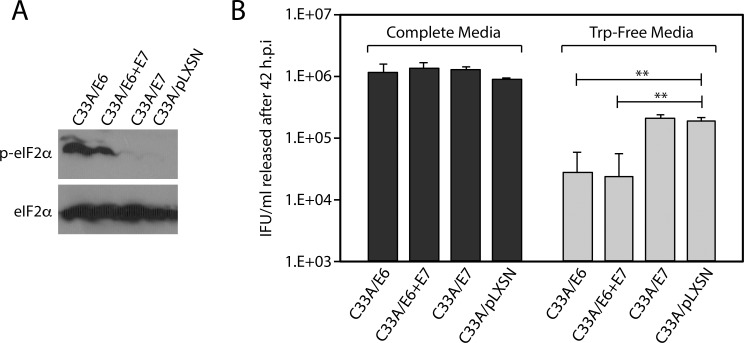
Expression of the HPV16 E6 oncogene in C33A cells accentuates the effect of tryptophan starvation on C. trachomatis development.Stable C33A-derivative cell-lines were constructed by transducing C33A cells with a control retroviral vector (pLXSN), or pLXSN derivatives expressing the HPV16 E6, E6 & E7, or E7 oncogenes. Stable cell-lines were selected using G418 as described in the material and method section. A) Cell-lines were grown in tryptophan-free media for 12 hours after which immunoblots were used to query the phosphorylation status of eIF2α. Total eIF2α was used as a loading control. B) IFU/mL recovered at 42 h.p.i. after infected cells were grown in complete media or tryptophan free-media, as evaluated by infection of HeLa cells. As anticipated, growth in tryptophan-free media reduced IFU/mL recovered from all four cell-lines. IFU/mL recovery from C33A/E6 and C33A/E6+E7 cell-lines during tryptophan starvation were significantly lower than the IFU/mL recovered from the control C33A/pLXSN cell-line. The data represent three independent experiments (** indicates P < 0.01 by the Wilcoxon rank sum test).